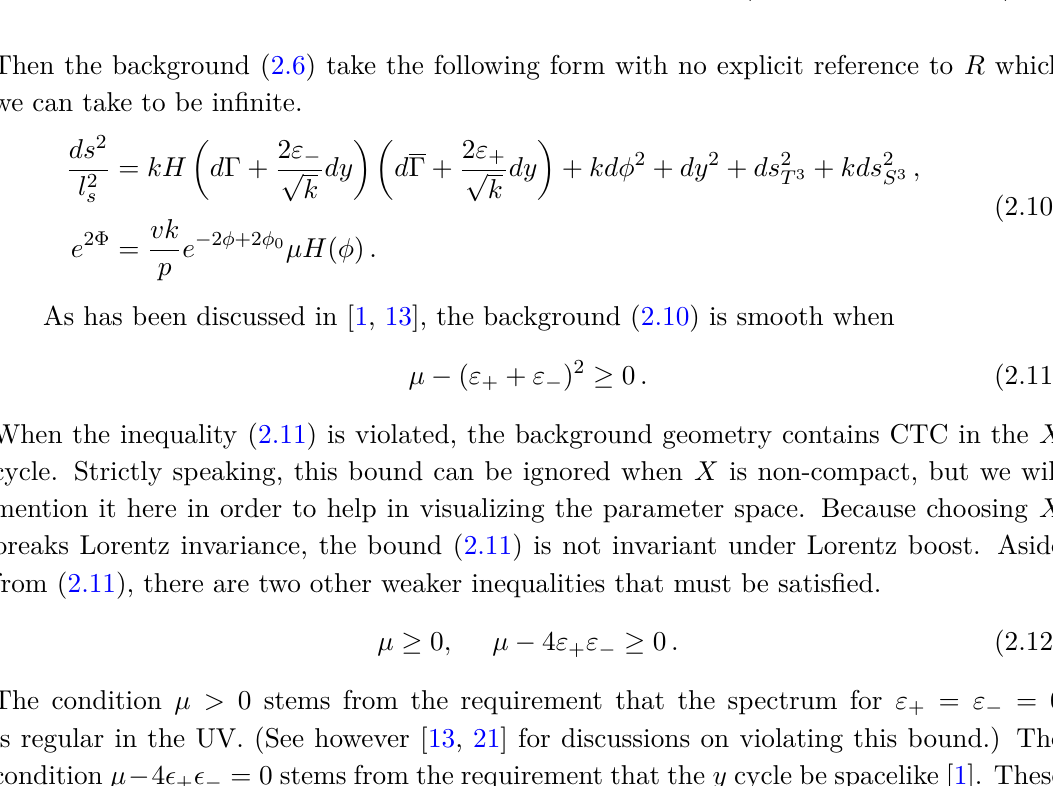
√ −√ µ/ 2 and ε + = ε − = µ/ 2